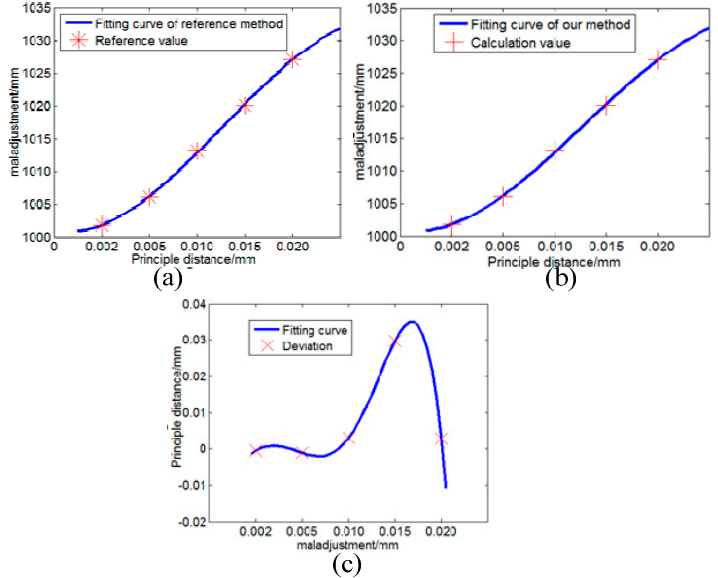
Figure 16. ( a ) Calibrated results of reference method; ( b ) the calibrated values of this method; and ( c ) the deviation between two different methods.